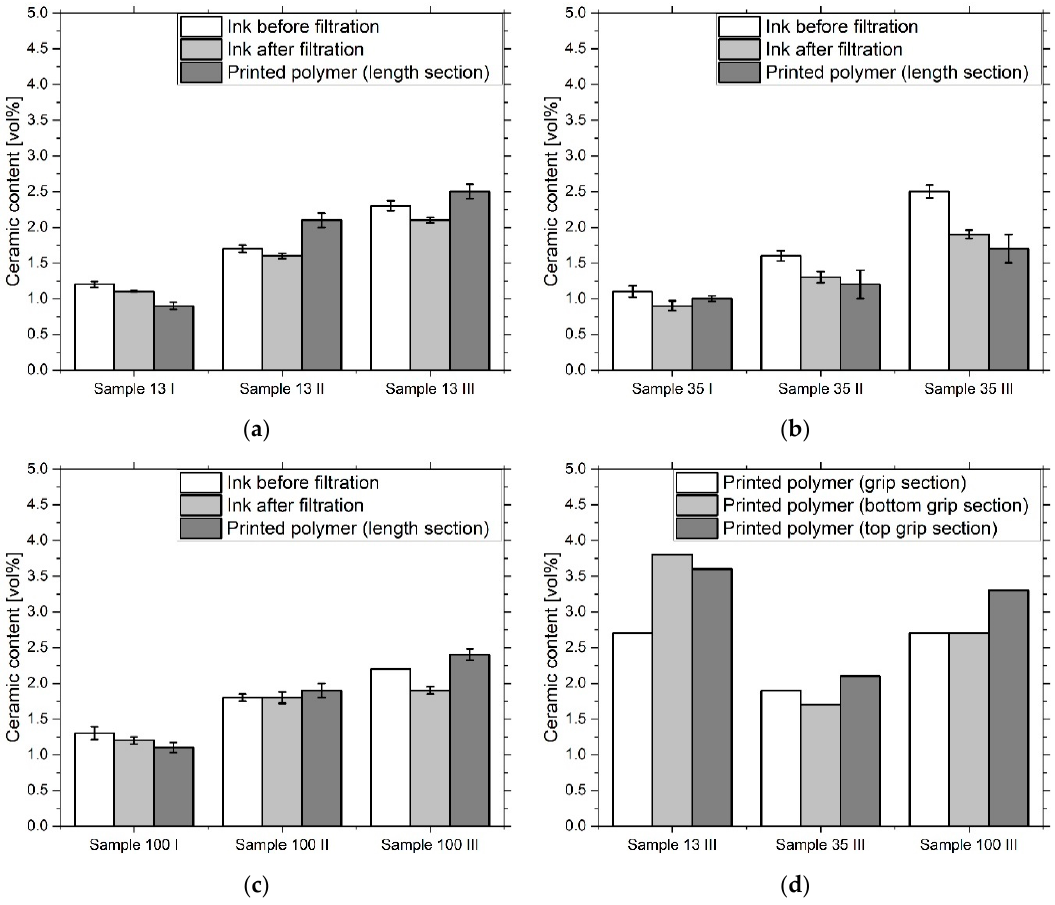
Figure 6. Ceramic content of the ink samples before and after filtration with a 5 µm filter and after printing and polymerization. The samples are 13 I, 13 II, 13 III ( a ), 35 I, 35 II, 35 III ( b ) and 100 I, 100 II, 100 III ( c ). The subsamples for the polymerized samples were taken in the longitudinal section of the tensile specimen. In ( d ) the ceramic content of samples 13 III, 35 III and 100 III is shown after the printing and polymerization. The subsamples were taken in the grip area, in the lower part of the grip and on top of the grip of the tensile specimen.